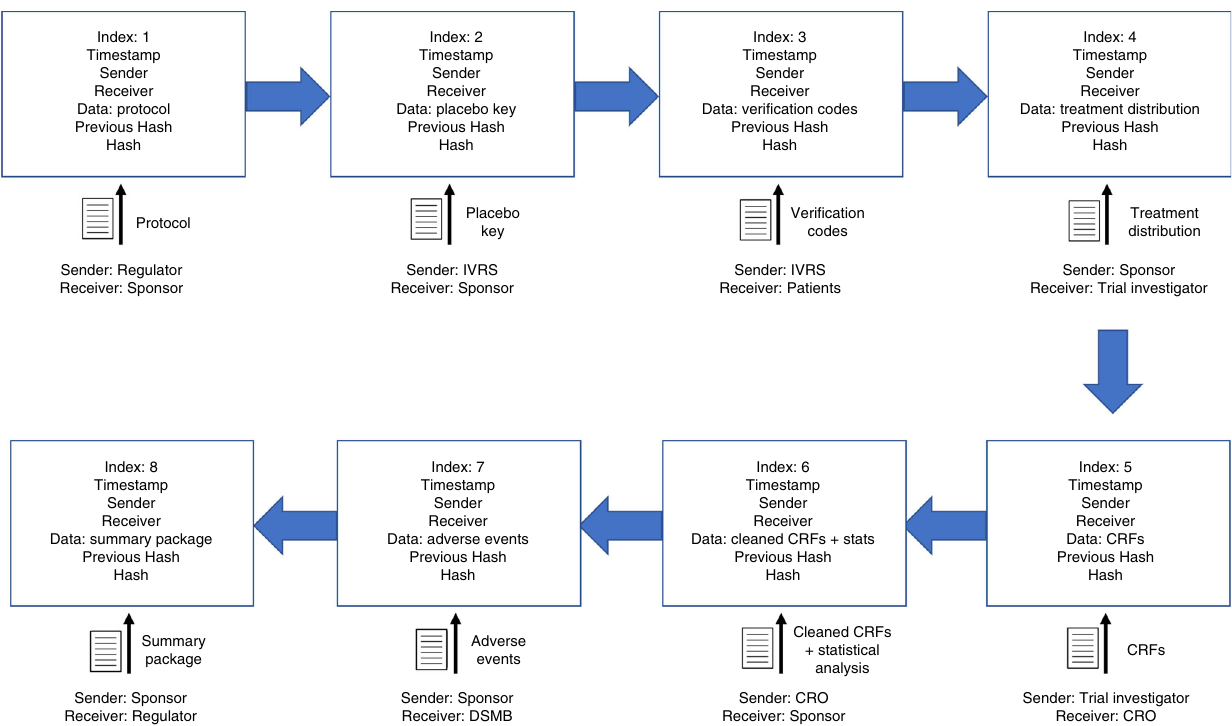
Fig. 2 The growing blockchain. With each new transaction that occurs, a block is appended and keeps track of information like the timestamp, sender, receiver, fi le contents, hash of the previous block, and current hash, all in an immutable data structure. On-chain storage of such elements requires minimal memory allocation linearly proportional to the amount of data being uploaded, since the additional book keeping elements are fi xed-length strings. Hence scalability is possible, especially given adequate allocation of hardware made possible via growing cloud storage capabilities (see Supplementary Discussion). A summary, compressed blockchain is shown. The actual blockchain will have a beginning genesis block and individual blocks for each transaction (such as a new block for each CRF instead of a single block for all CRFs as shown). The compressed chain is shown to illustrate the